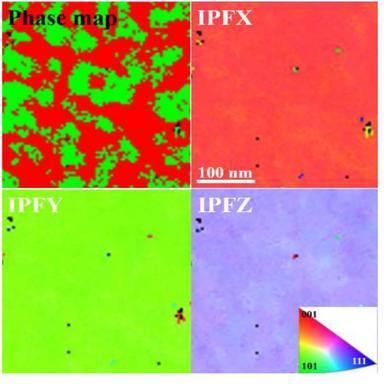
(a) TKD analysis (step size = 10 nm) on TEM sample 1 showing the pattern quality map (top left), phase map (austenite phase in red and spinel oxide phase in green, top right), IPFX map (middle left), IPFY (middle right), and IPFZ (bottom); (b) TKD analysis on TEM sample 2 (step size = 3 nm) showing the phase map (austenite phase in red and spinel phase in green, top left), IPFX map (top right), IPFY (bottom left), and IPFZ (bottom right).